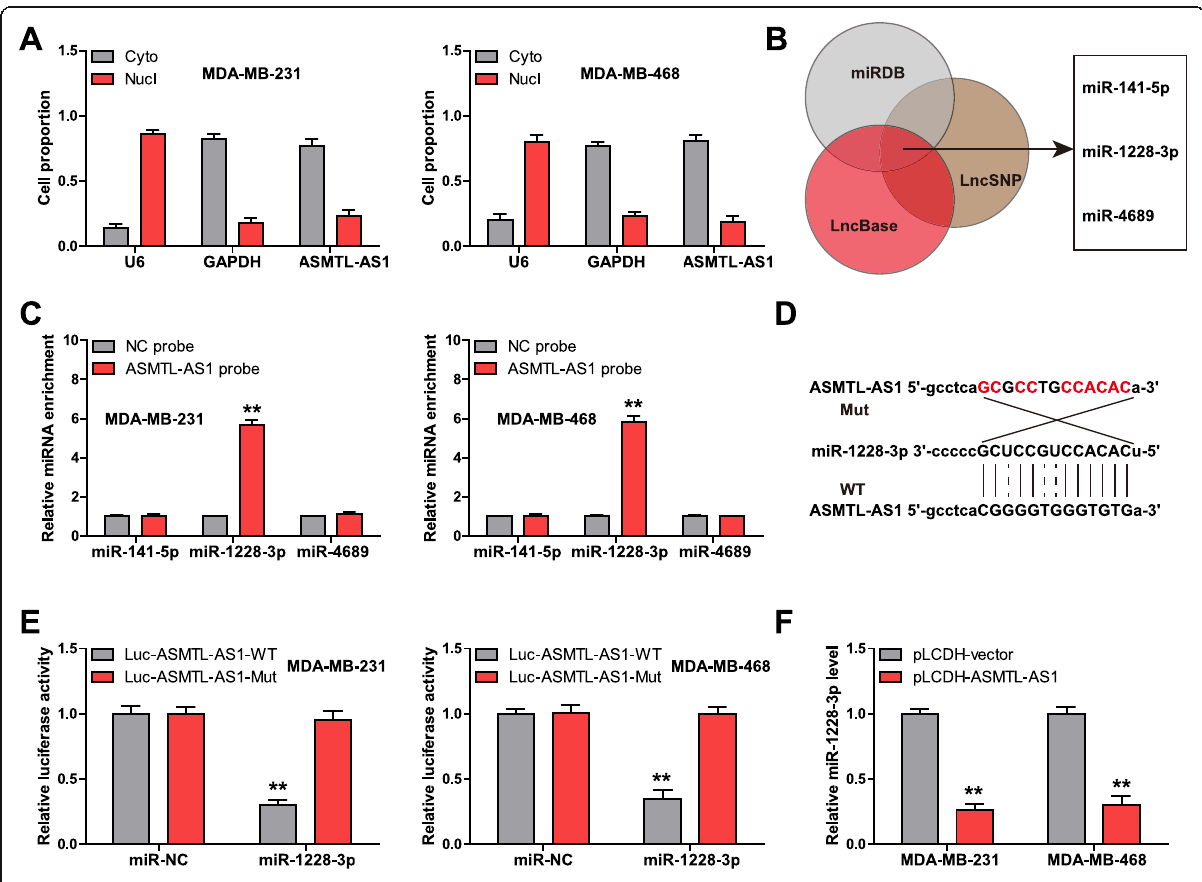
Fig. 3 miR-1228-3p is a target of ASMTL-AS1. a qRT-PCR analysis of location of ASMTL-AS1 in MDA-MB-213 and MDA-MB-468 cells. b Three databases predicting miRNAs bound by ASMTL-AS1. c RNA pull-down assay using ASMTL-AS1 probe, followed by qRT-PCR analysis of miRNA enrichment. d , e . The binding site between ASMTL-AS1 and miR-1228-3p, followed by mutation and luciferase reporter assay. f . qRT-PCR analysis of miR-1228-3p level after ASMTL-AS1 overexpression. ** P <